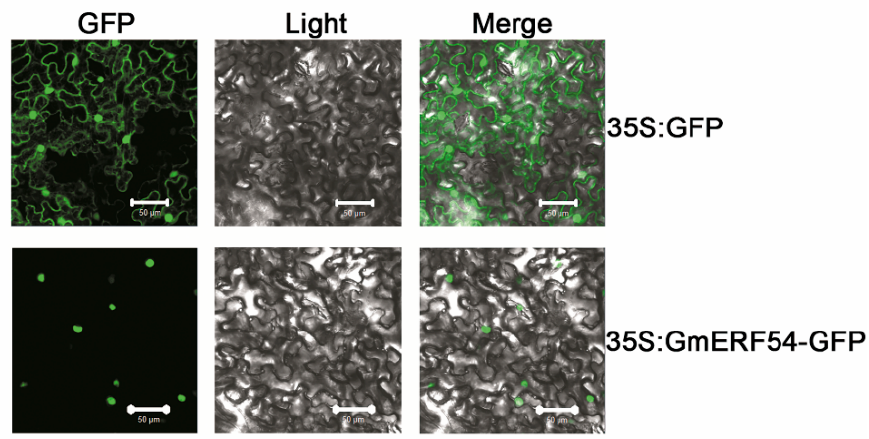
Figure 3. Subcellular localization of GmERF54 in tobacco mesophyll cells. GFP represents GFP fluo- rescence, light represents the bright field, and merge represents the combination of GFP fluorescence and the bright field. Scale bars: 50 µ